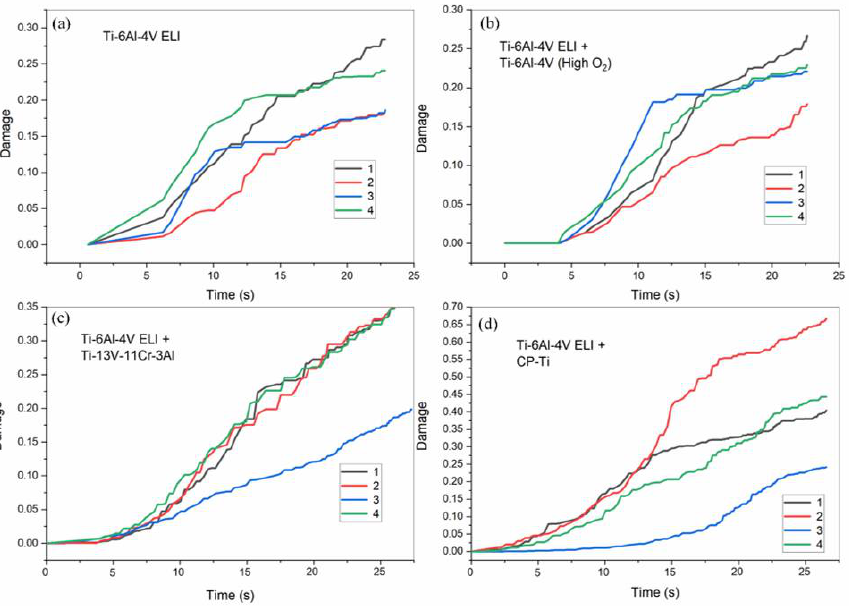
Figure 9. Damage induced during the forging process at the four different points ( a ) Part 1, ( b ) Part 2, ( c ) Part 3, and ( d ) Part 4.